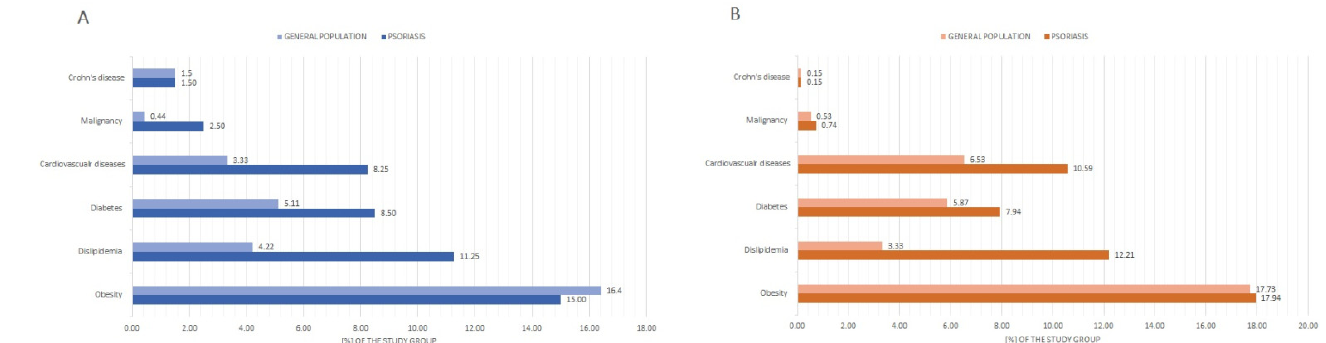
Figure 5. The comparison of concomitant diseases among psoriasis patients and general population. ( A ) Female psoriasis patients vs. female control group. ( B ) Male psoriasis patients vs. male control group.